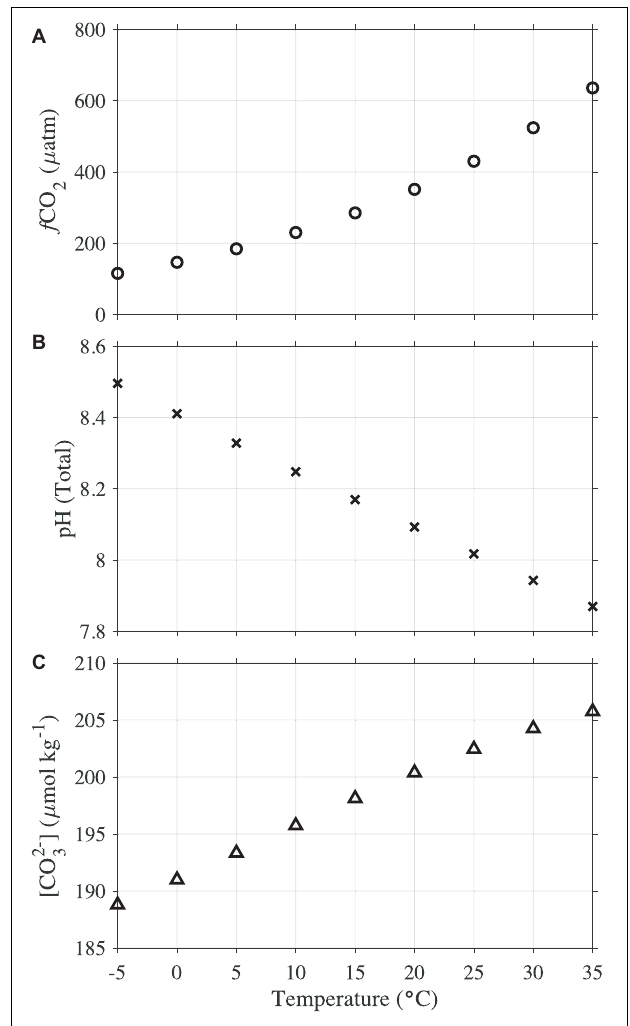
FIGURE 4 | Temperature dependencies of (A) fugacity of carbon dioxide ( f CO 2 ); (B) pH on Total Scale; and (C) carbonate ion content. The calculation is based on an imaginary seawater with the global average surface ocean temperature, salinity, DIC, and TA of 19.23 ◦ C, 34.87, 2020 µ mol kg − 1 , and 2306 µ mol kg − 1 , respectively (Jiang et al., 2015b) and using the recommended constants that are given in the section “Recommended Dissociation Constants and Other Values for Carbon System Calculations” of the Supplementary Material